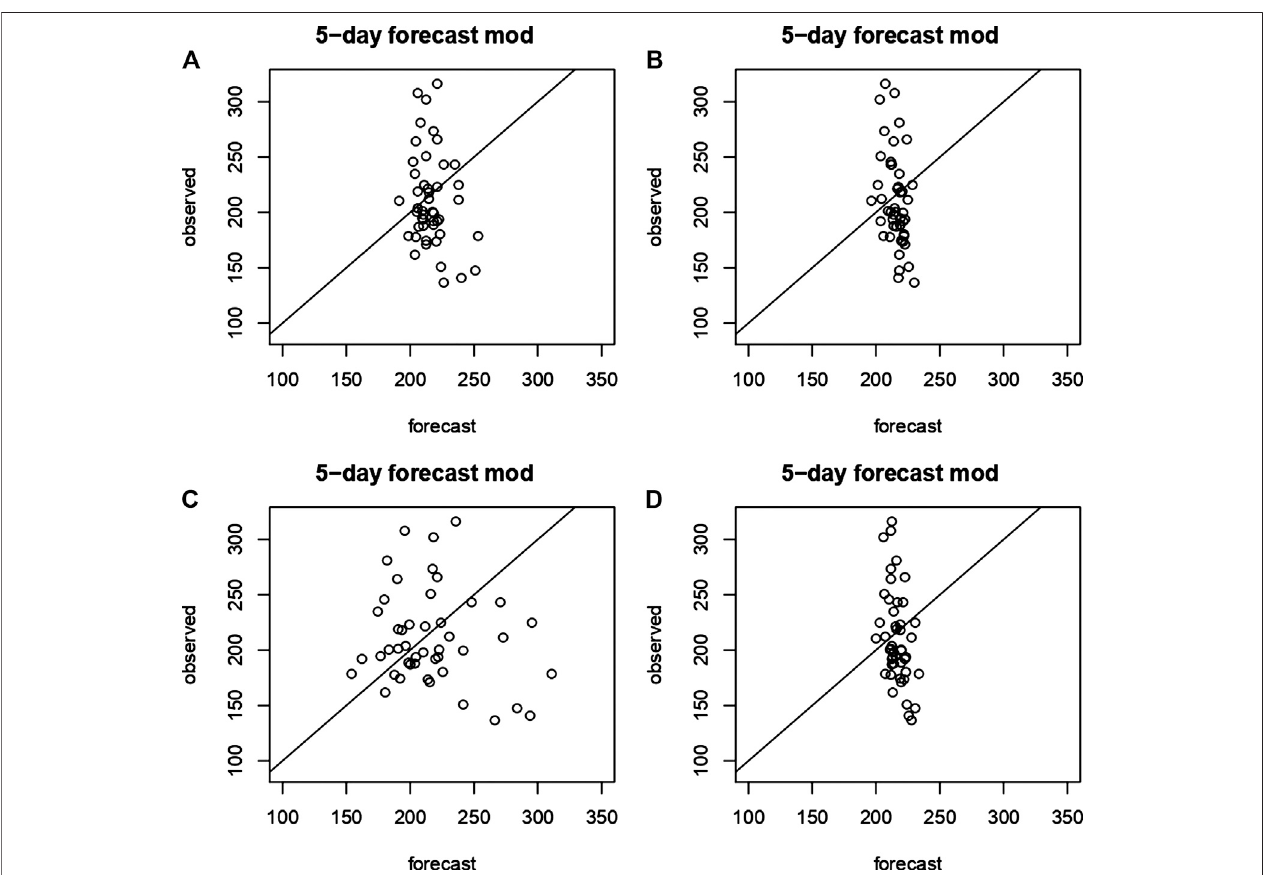
FIGURE 8 | Prediction at 5-lag and observed radon measurements for the estimated Models (A – D) as labeled in Table 1 .